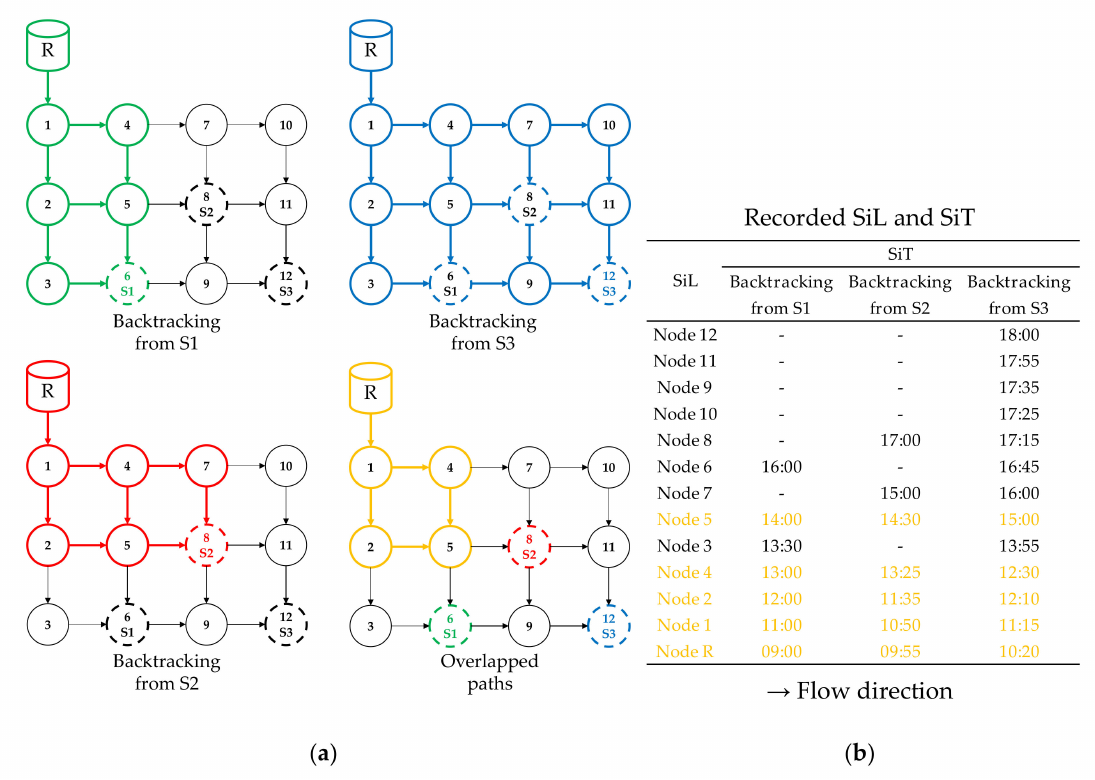
Figure 5. Backtracking results of the sample network: ( a ) Backtracking paths and ( b ) Recorded SiL and